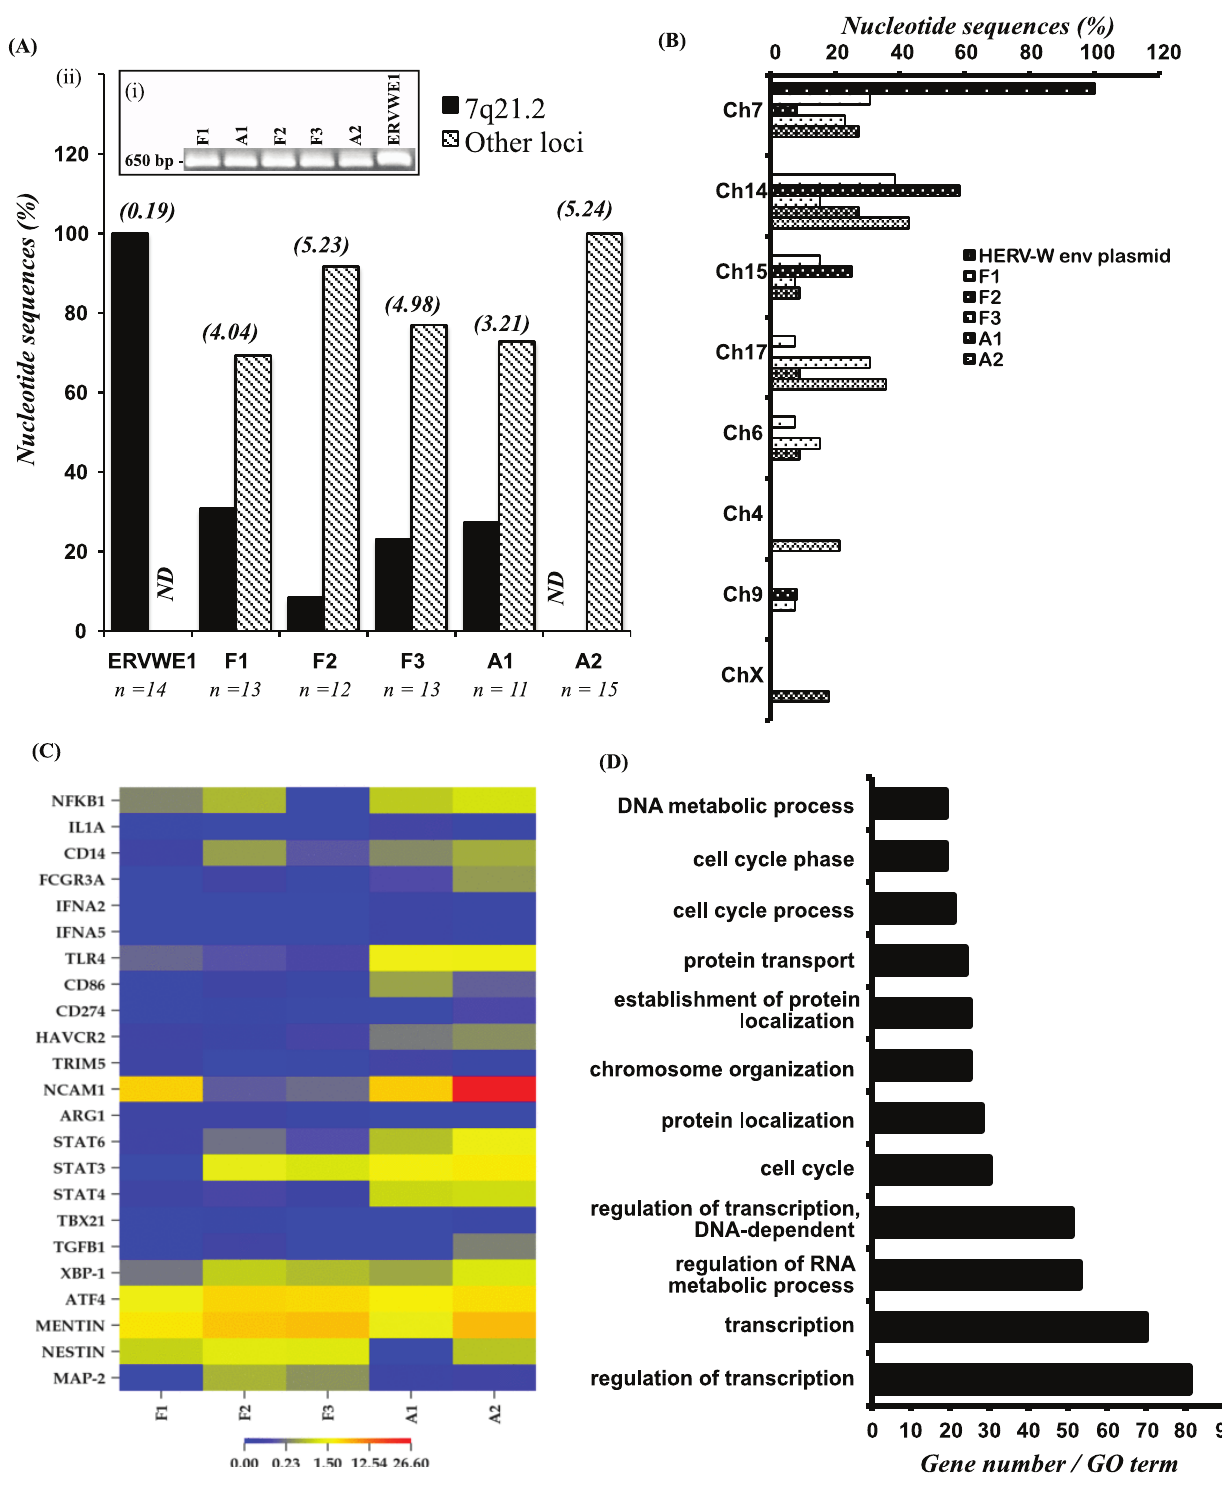
Figure 5. HERV-W env sequence analyses in healthy brain specimens. ( A ) ( i ) Ethidium-stained agarose gel of amplicons after second PCR step from fetal (F) and adult (A) brain samples. ( ii ) Relative clonal frequency of transcriptionally active HERV-W env sequences in fetal and adult brain samples showing encoding loci to be 7q21.2 and other sites. Diversity relative to ERVWE1 is displayed in parenthesis. ( B ) Chromosomal loci distribution of transcriptionally active HERV-W env sequences in fetal and adult brain samples. ( C ) Heatmap of gene expression was generated from RNA tags obtained by deep sequencing analysis by selecting a set of host genes relevant to neuroinflammation and associated with HERV-W env abundance in the sample. Over-expressed genes are shown in red and under-expressed in blue. ( D ) Host genes with expression profiles highly correlated with HERV-W env tag abundance (r 2 $ 0.75) were analyzed using DAVID tools (http://david.abcc.ncifcrf.gov/) for enriched gene ontology (GO) terms. Genes related to transcriptional activity and regulations were strongly associated with HERV-W env expression. (ND=none detected).